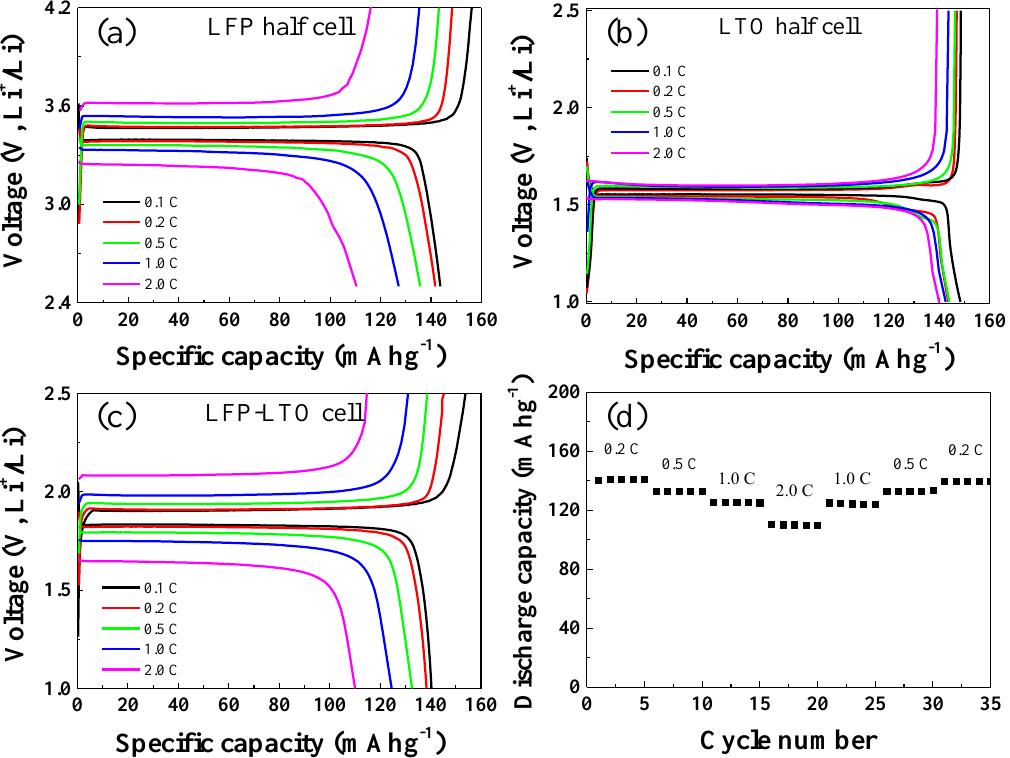
Figure 4. Electrochemical properties of the ( a ) LFP-Li, ( b ) LTO-Li, and ( c ) LFP-LTO cells and ( d ) rate capability of the LFP-LTO cell measured at various C-rates.